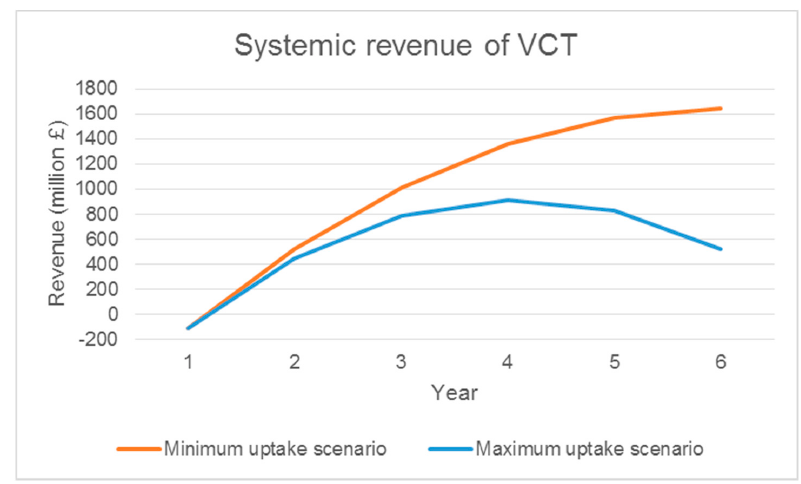
Figure 1. Systemic revenue of the Variable Council Tax (VCT) over the duration of the policy.